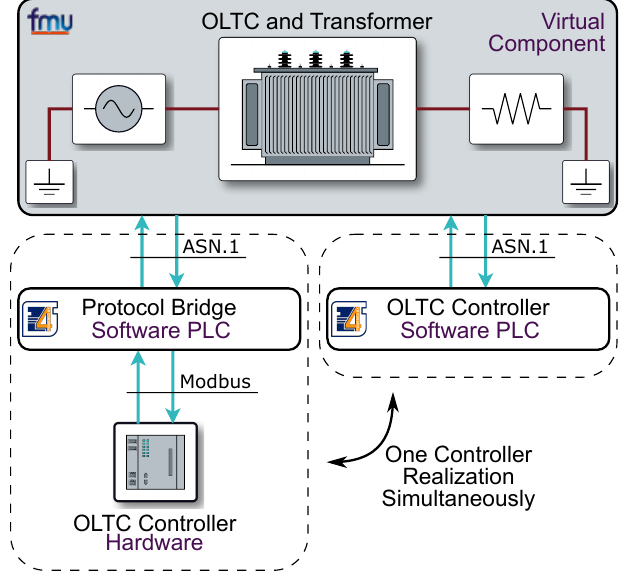
Figure 4. Experimental